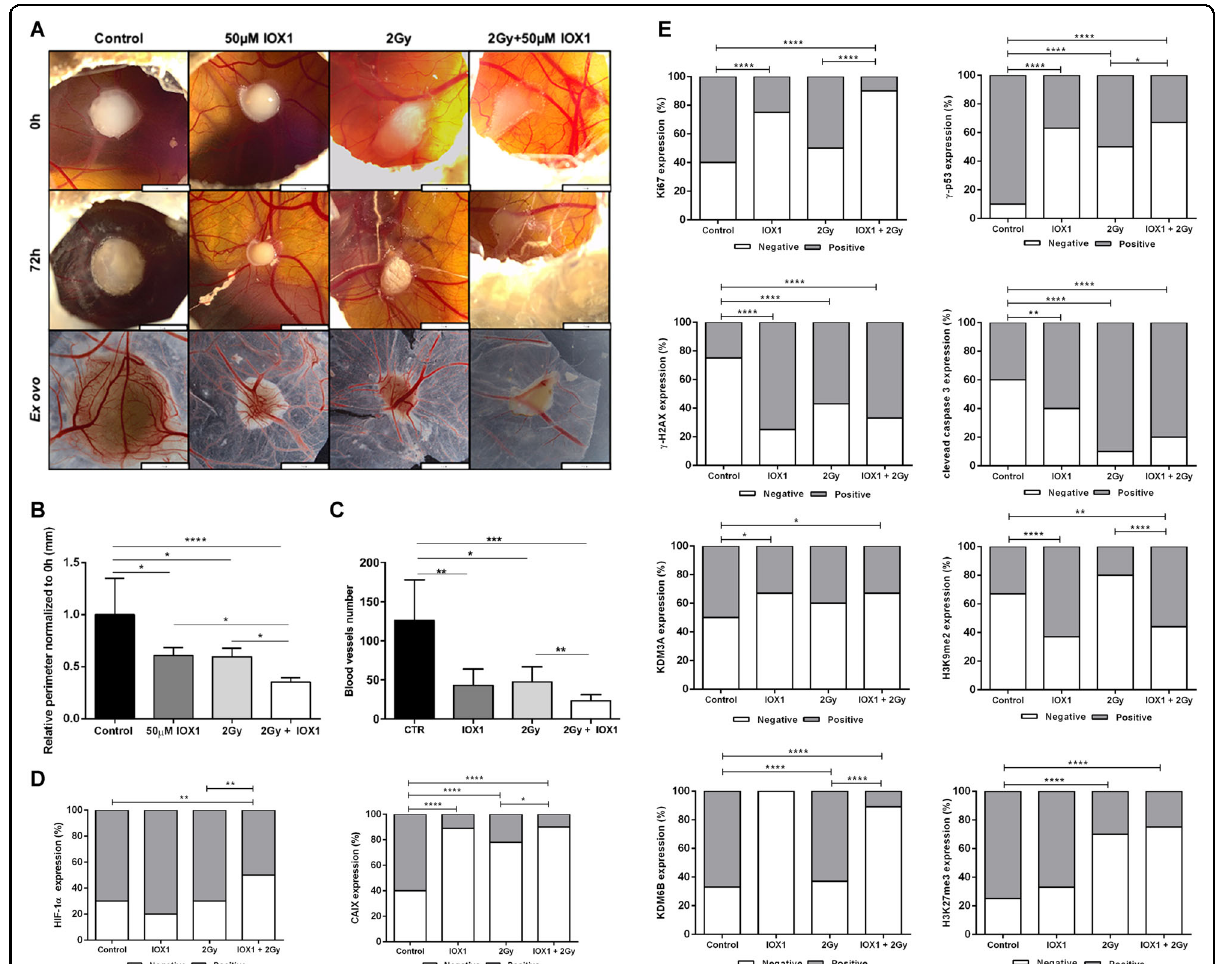
Fig. 6 IOX1 effect in irradiated ESCC microtumors in in vivo CAM assay. a Representative pictures of CAM microtumors for treatment conditions at 0 h and 72 h. Digital images were taken under a stereomicroscope Olympus S2X16 using a digital camera Olympus SC180 (scale bar 1 mm). Relative perimeter (mm) ( b ) and blood vessel recruitment ( c ) of ESCC microtumors normalized to 0 h of drug treatment. Results are presented as mean±SD of 10 eggs per group condition; * p < 0.05; ** p < 0.01; *** p < 0.001. Graphical re p resentation of ( d ) hypoxic markers (CAIX and HIF-1 α ) and ( e ) Ki-67, γ -p53, cleaved caspase 3 and γ -H2AX, as well as KDM3A, KDM6B, H3K9me2, and H3K27me3 immunostaining for ESCC microtumors sections; * p < 0.05; ** p < 0.01; *** p < 0.001; **** p <